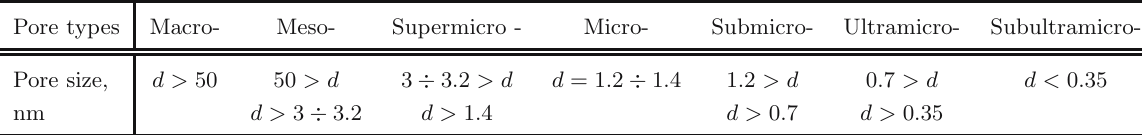
Table 2 Unified pore size